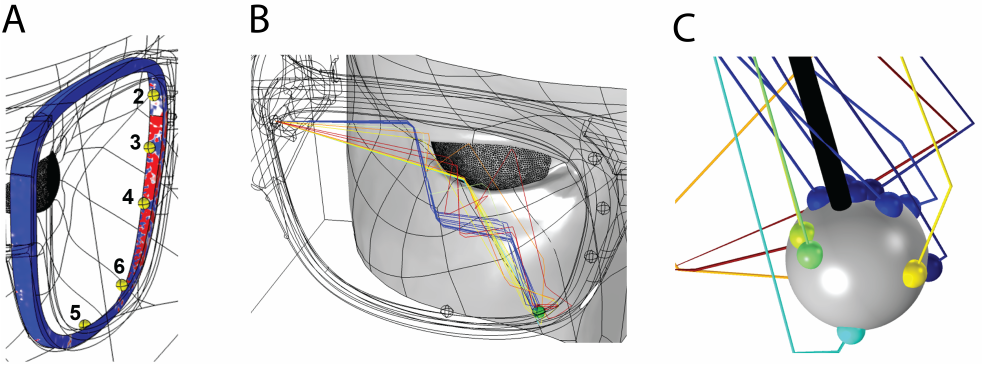
Figure 9. Signal detection: ( A ). Rays reflected from the eye; ( B ). Subset of rays arriving at sensor 6; ( C ). closeup of rays arriving at sensor